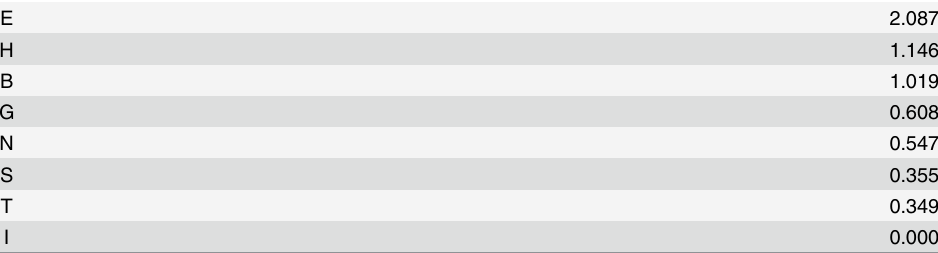
Table 2. Incidence of different residues on key positions related with